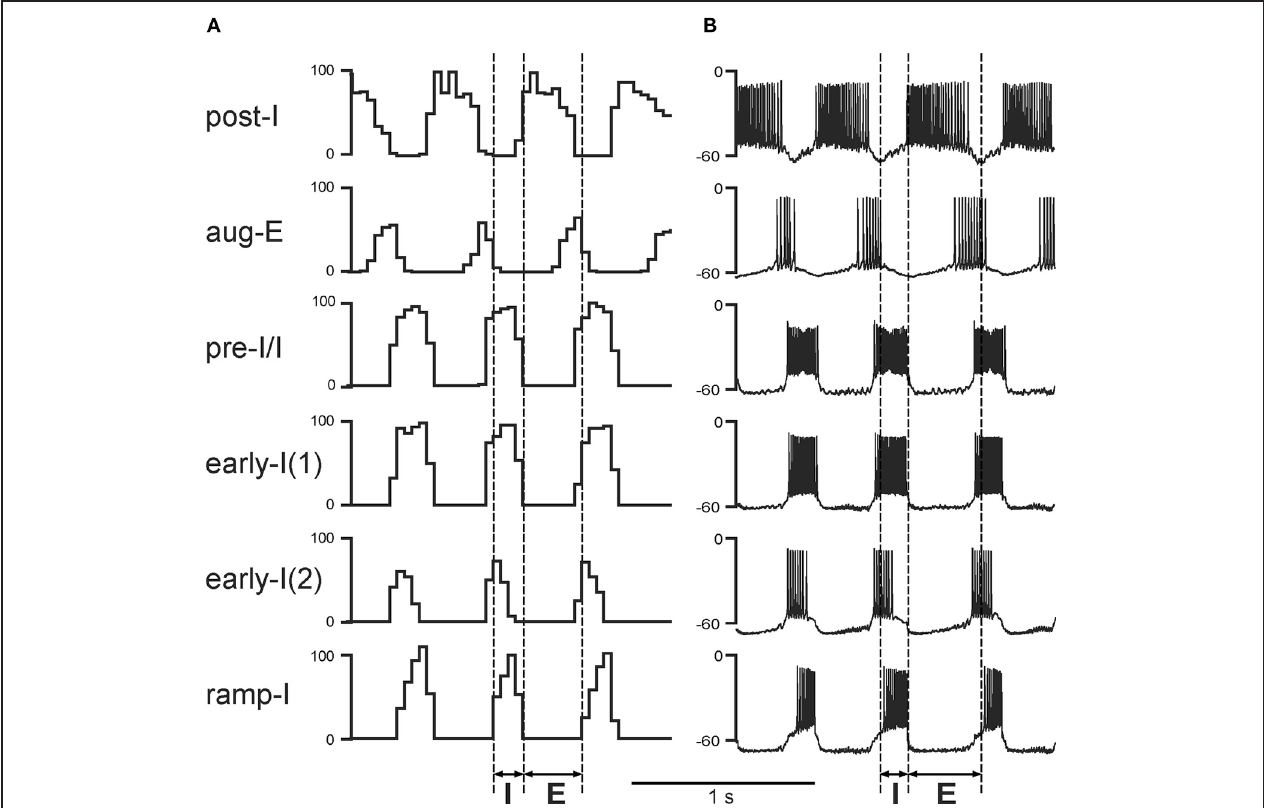
FIGURE 2 | Performance of the core medullary network under normal conditions (with both feedbacks intact). (A) The activity of main neural populations of the core respiratory network under normal conditions. The shown population activities include (top–down): post-inspiratory (post-I) and augmenting expiratory (aug-E) (both in BötC); pre-inspiratory/ inspiratory (pre-I/I) and early-inspiratory [early-I(1)] (both in pre-BötC);